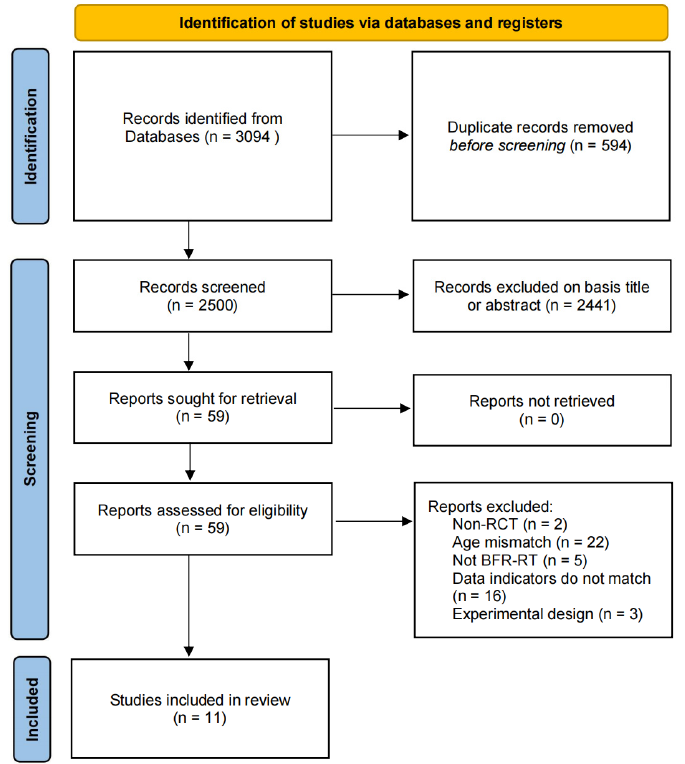
Figure 1. Flowchart of studies selection process.